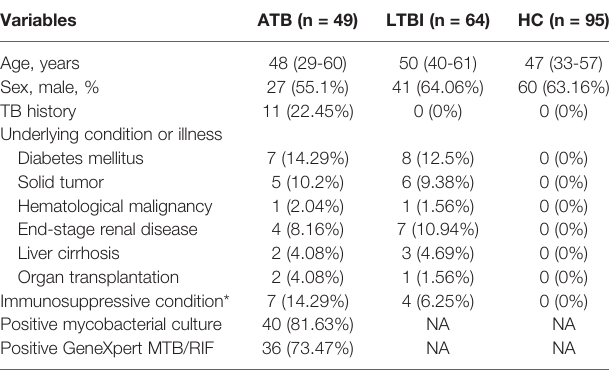
TABLE 1 | Demographic and clinical characteristics of included